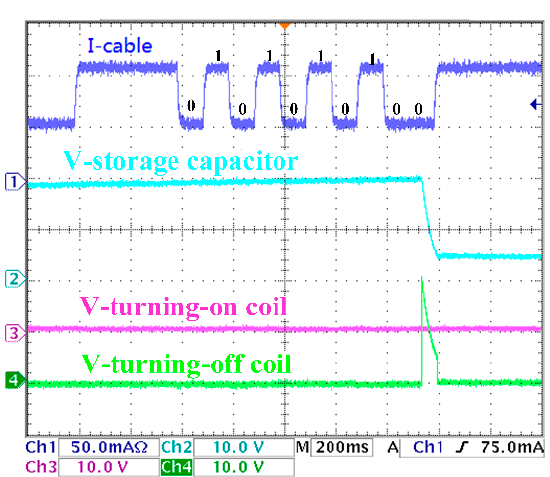
Figure 19. Error parity command.